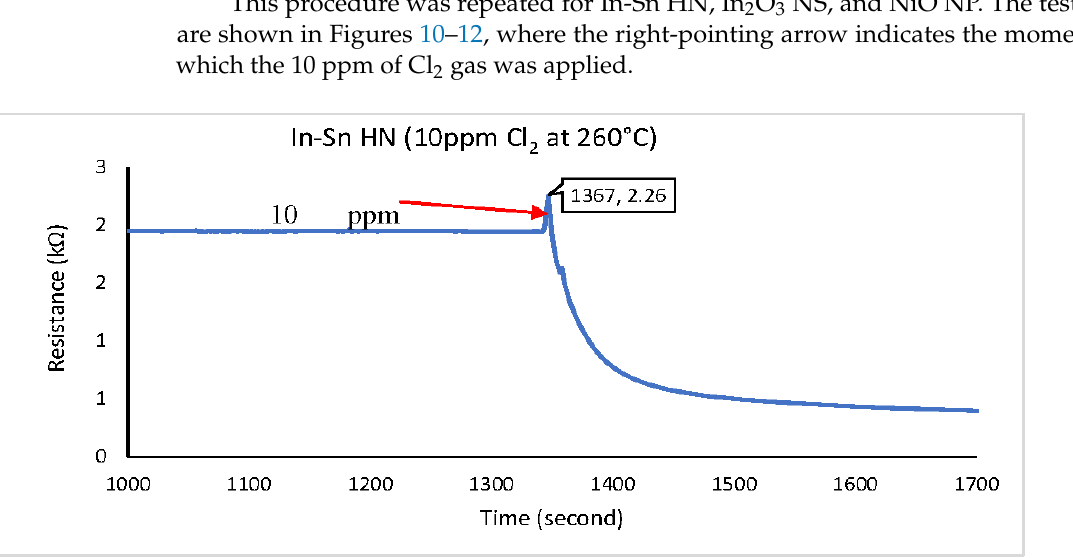
Figure 10. Cl 2 response for In-Sn HN material at 260 °C.